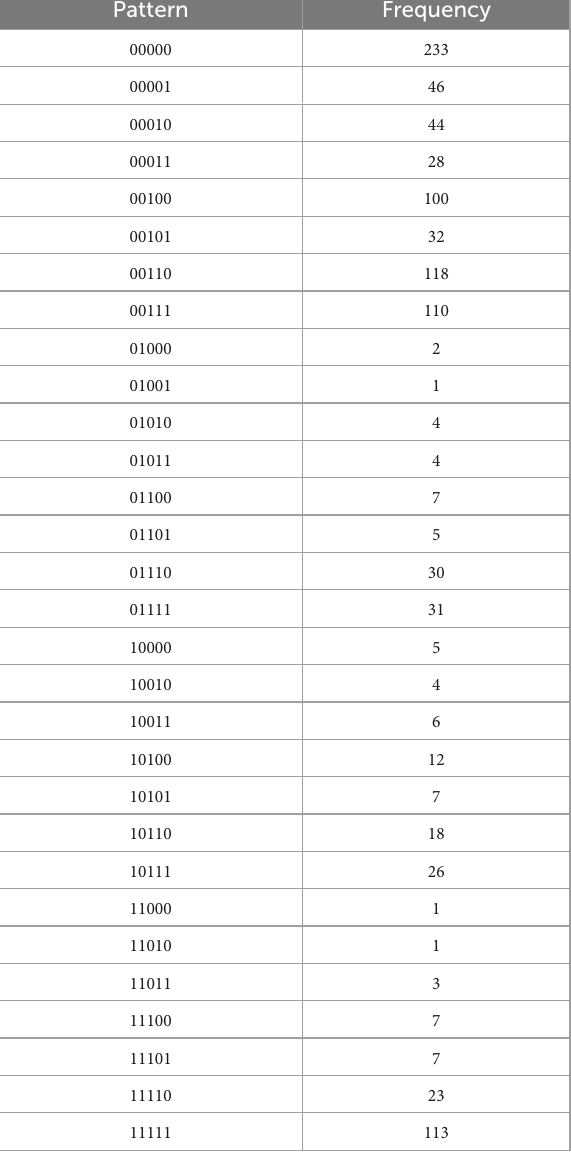
TABLE 4B External regulation, with N = 1028, k = 5 items, and u = 30 unique response patterns ( Appendix B